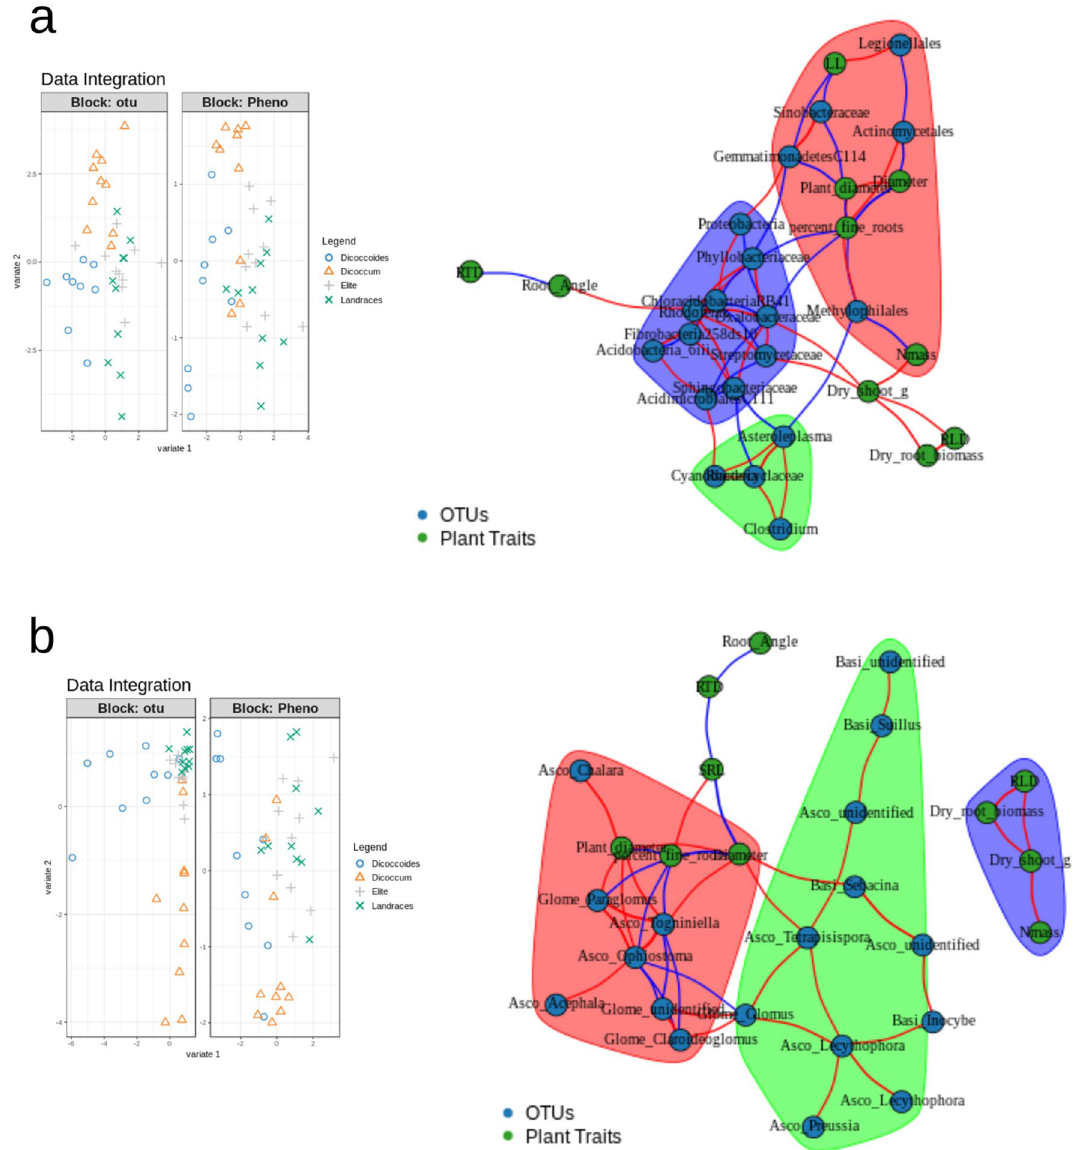
Figure 4. Network visualization of associations between bacterial and fungal OTUs abundances, and ten above and belowground plant traits across the four domestication groups. Green and blue nodes correspond to plant phenotypic traits and bacterial ( a ) or fungal ( b ) OTUs, respectively. Edges indicate positive (red) or negative correlations (blue) as defined by Pearson’s correlation coefficients r > 0.4 or r < − 0.4, respectively. Different modules are represented by different colors (green, red, and blue). Left panels are showing discrimination of the samples based only on the sub-selected OTUs and plant traits that